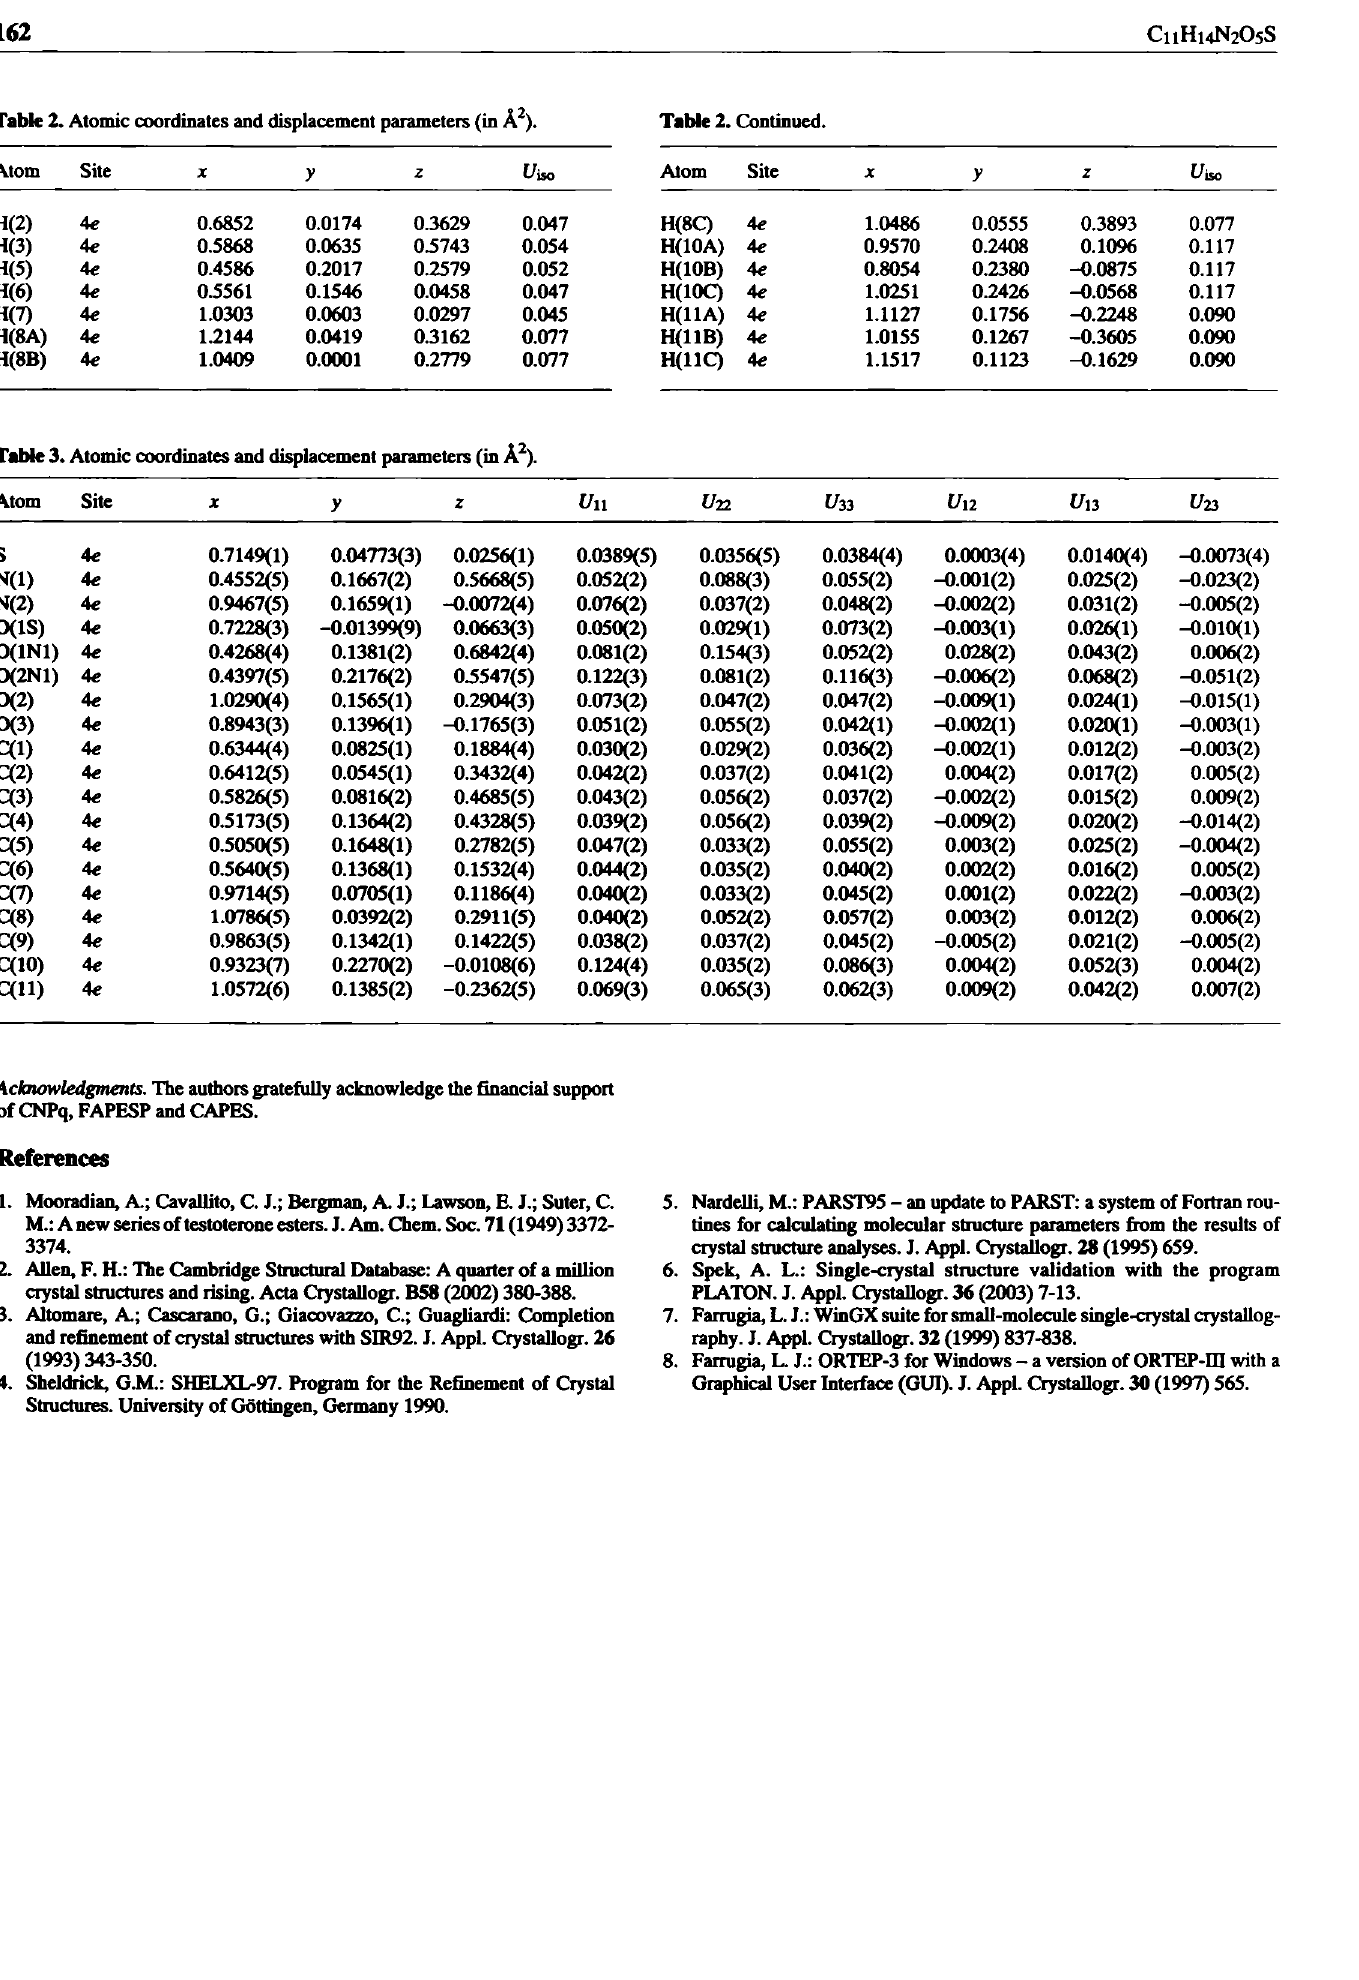
Table 2. Atomic coordinates and displacement parameters (in A 2 ).